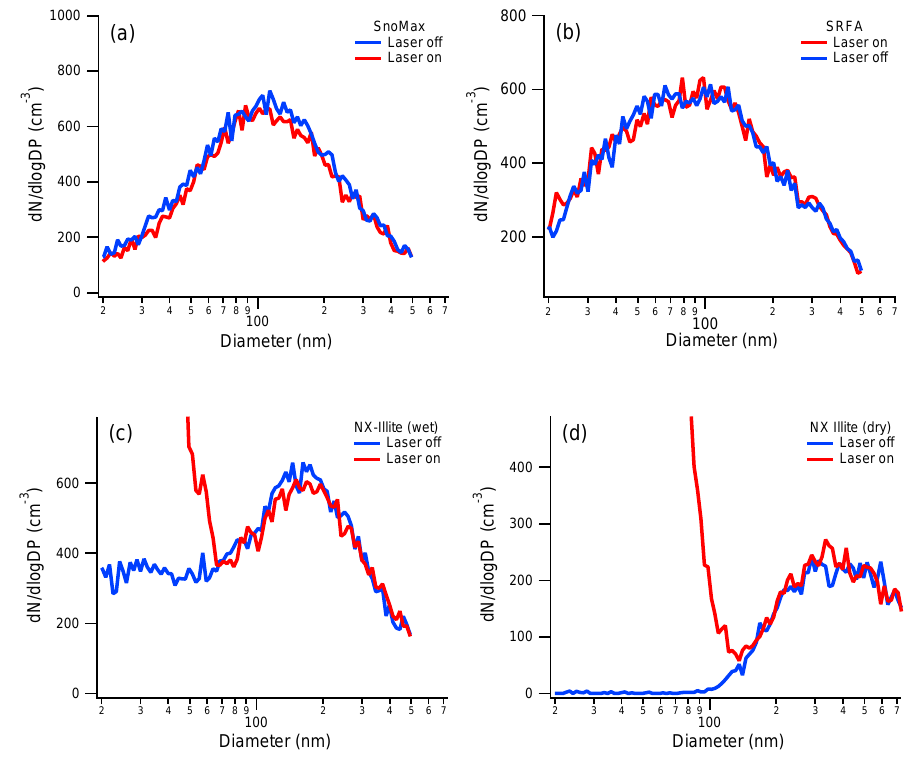
Figure 6. The size distribution of Snomax ® (a) , SRFA (b) , wet-generated NX-illite (c) , and dry-generated NX-illite (d) . The size distributions were measured when the SP2 laser was both on and off. As shown, both Snomax ® and SRFA are unaffected by the SP2 laser. A new particle peak does appear for NX-illite when the SP2 laser is on, but the original size distribution is minimally